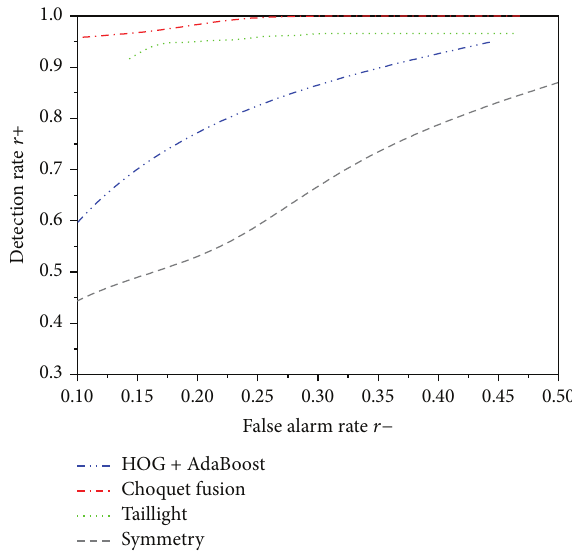
Figure 10: Algorithm ROC